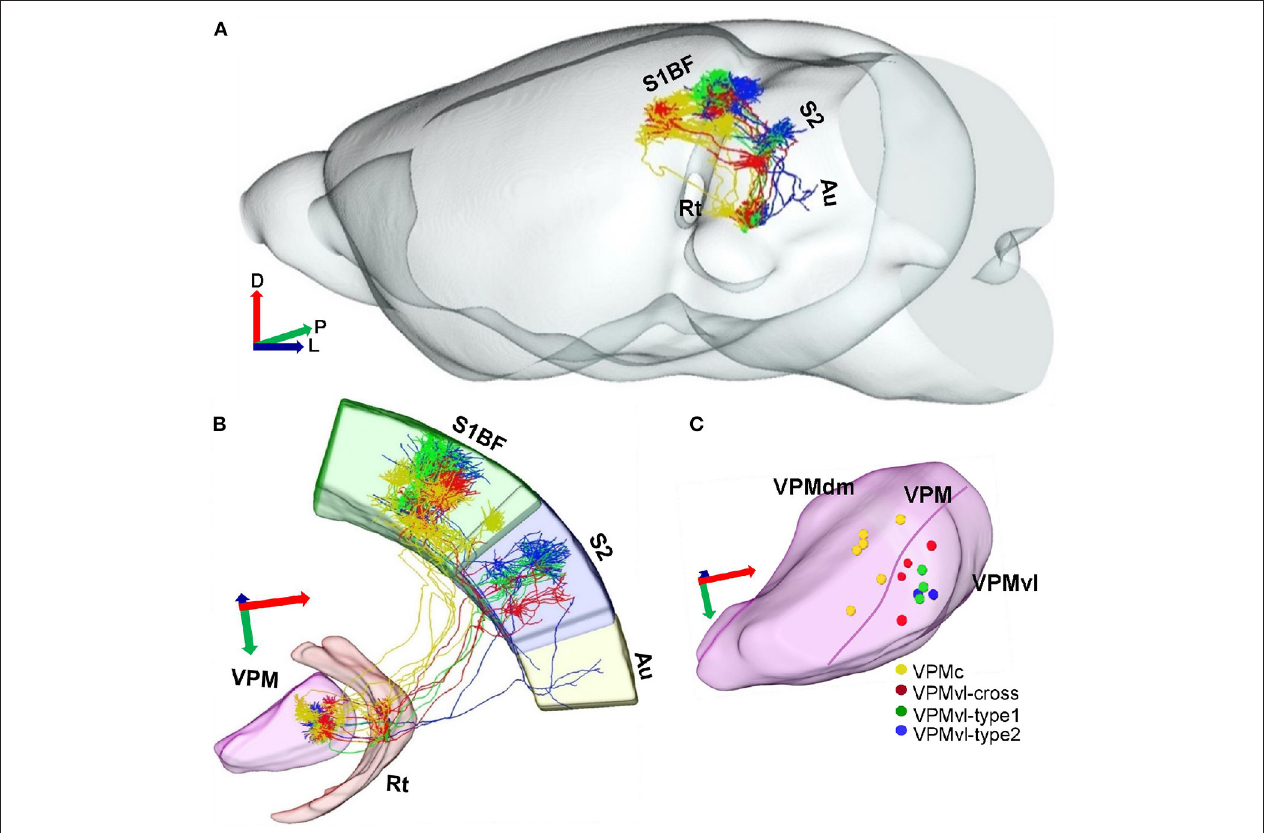
FIGURE 4 | Projection organization of four different VPM subgroups. (A) Overlay of 15 reconstructed VPM neurons registered into a reference brain. Gray represents the outer contour of the mouse brain. Yellow lines indicate VPMc morphologies. Green lines indicate VPMvl-cross morphologies. Red lines indicate VPMvl-type1 morphologies. Blue lines indicate VPMvl-type2 morphologies. (B) Fifteen reconstructed VPM neurons and fiber distribution. (C) The soma localization of four subgroups in different VPM subregions. D, Dorsal; P, Posterior; L,